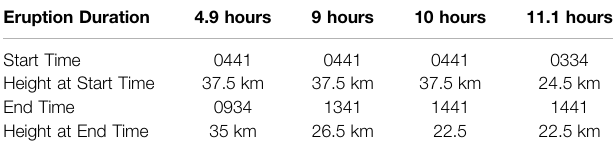
TABLE 3 | The starting and ending time (UT) for simulating the climactic phase of Pinatubo eruption on June 15, 1991. Observed plume height (Holasek et al., 1996a) at different times is also listed in the